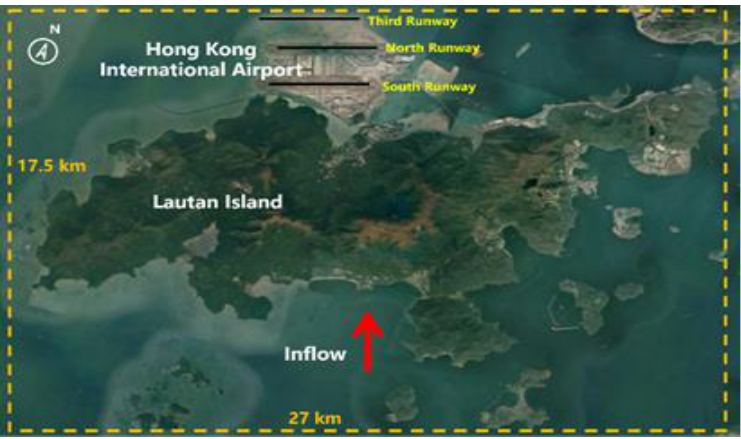
Figure 4. Hong Kong International Airport and surrounding terrain.